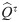
Influence of choice for τest on accuracy of recovered C.A Best estimated matrices C for τest = 0, 0.1, 1 and 5 s. For τest = 1, the C matrix at the end of the optimization (step 10000) is also shown. B Evolution of Q errors for the optimizations with various τest in A. bf C C errors corresponding to the best matrices in A (red solid curve), as well as last matrices of the optimization (red dashed curve). The green curve indicates the error of the best C with the symmetric part of the original C. The blue curve indicates the error between the empirical Q^τ and the corresponding theoretical matrix. D Pearson correlation coefficient between the best and original C (red) as well as reconstructed and objective Q0/τ. between Q^τ and each corresponding theoretical Qτ matrix for the same τ = τest in C. E Comparison between LO with empirical Q^ calculated with Eq (2) (red solid curve) and LO with theoretical Q^ obtained from Eq (7) (red dashed curve). The blue curve indicates the inaccuracy between the empirical and theoretical Qτ matrices. F Same as B for the Q error with theoretical objectives Q^0/τ.